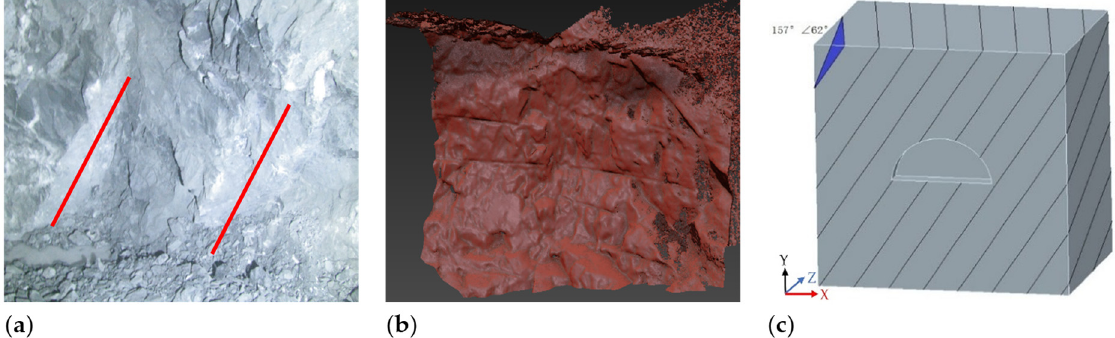
Figure 2. Monitoring section DK 149 + 928–DK 149 + 957 structural surface information: ( a ) visible light photo of the rock wall; ( b ) 3D scan of the rock wall; and ( c ) geometric model.